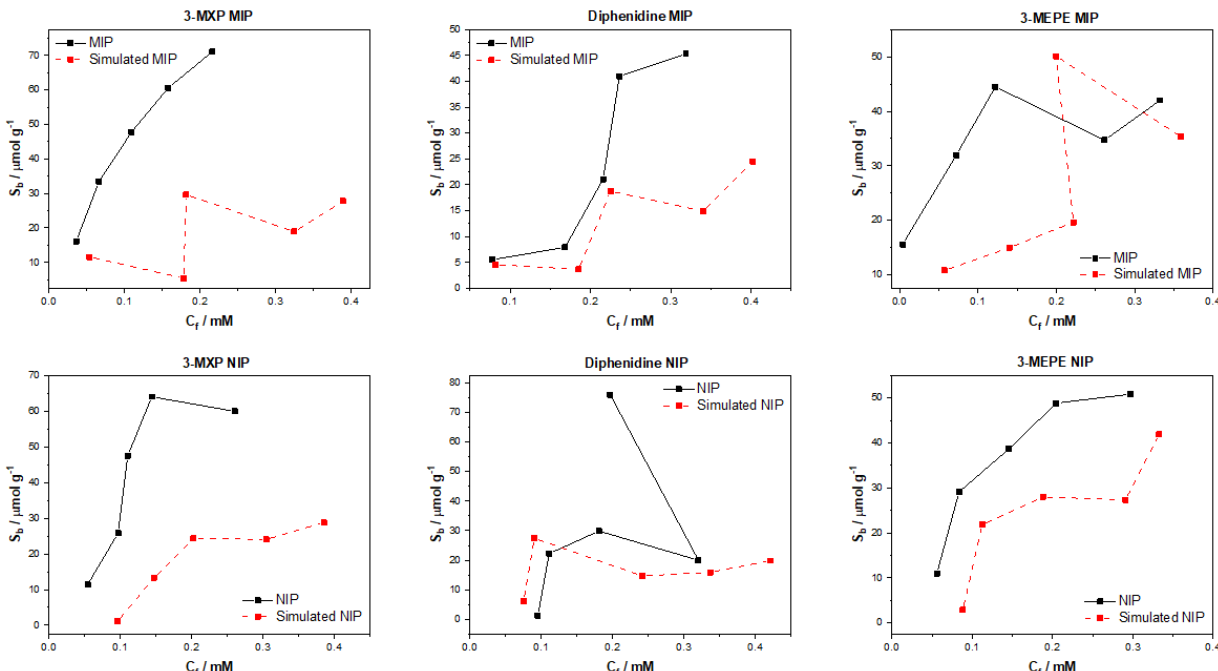
Figure 9. ChemCeption model with SMILEStoImage featurizer simulated and experimental binding isotherms for MIP and NIP in regard to the binding of 3-MXP, diphenidine, and 3-MEPE.